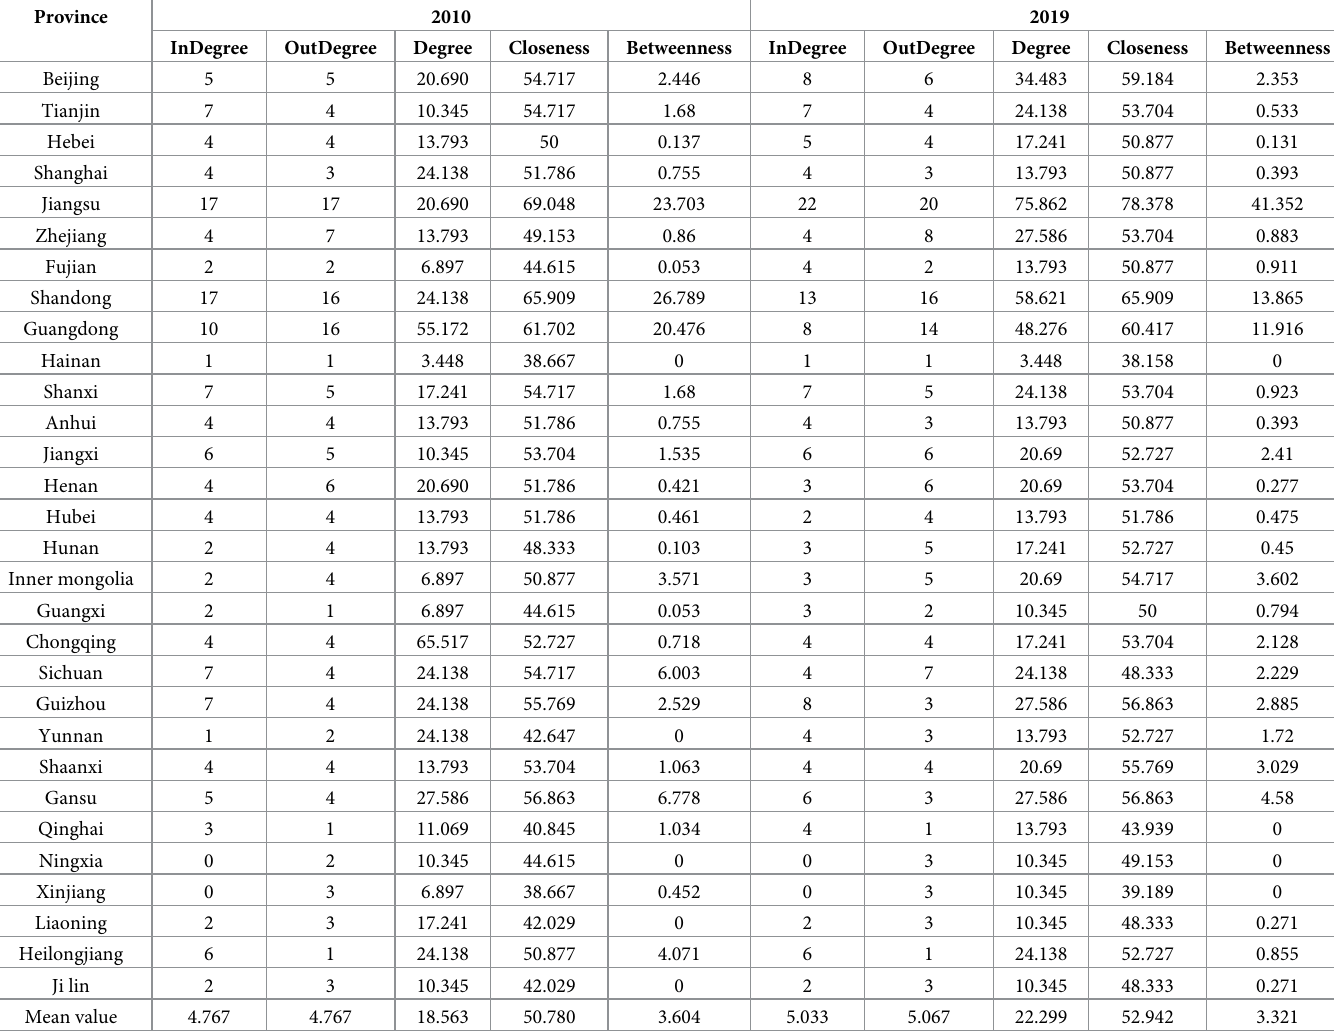
Table 3. Centrality characteristics of spatial correlation network of tourism eco-efficiency of China in 2010 and